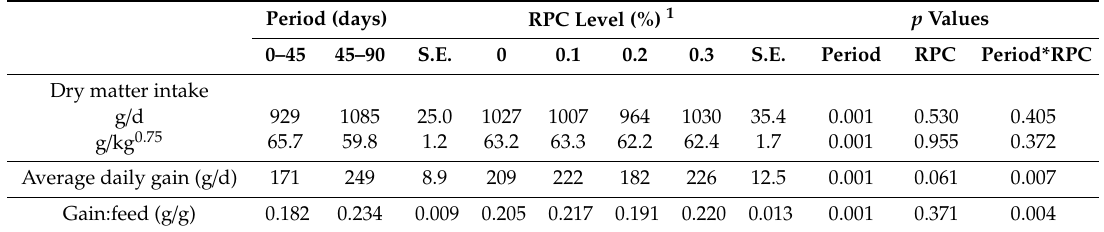
Intake, weight gain, and gain:feed of lambs fed finishing diets containing various rumen-protected choline (RPC)